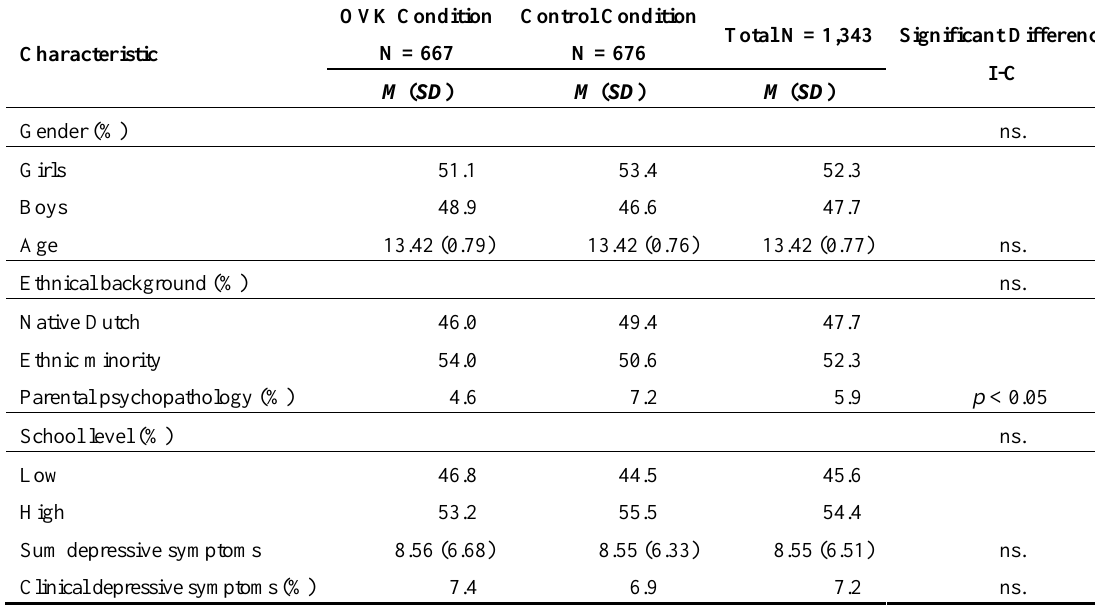
Table 1. Baseline